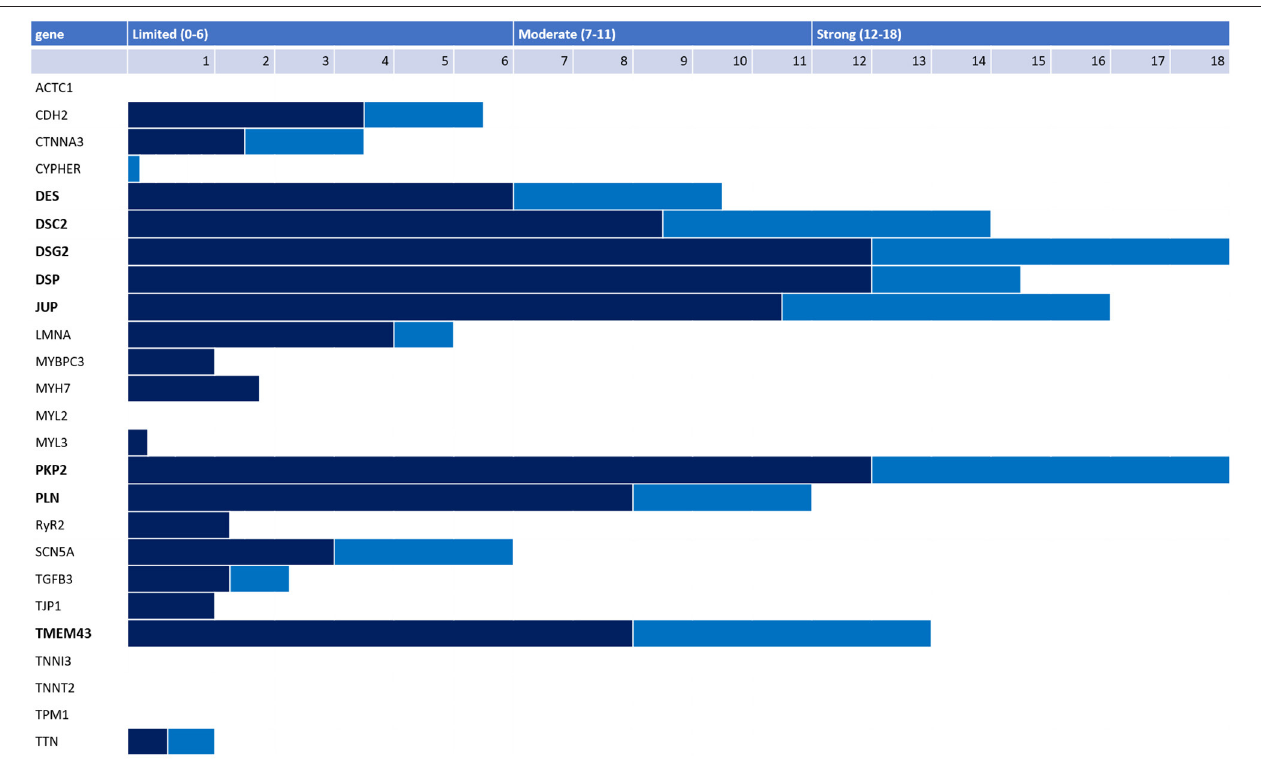
FIGURE 4 | Adjudication of 26 genes reported as ARVC-causing in the literature by an international expert panel. Genetic (dark blue) and experimental (light blue) evidence and final classification 26 genes reported in the literature as associated with ARVC per the ClinGen framework. Only 8 genes had strong or moderate evidence for ARVC causality